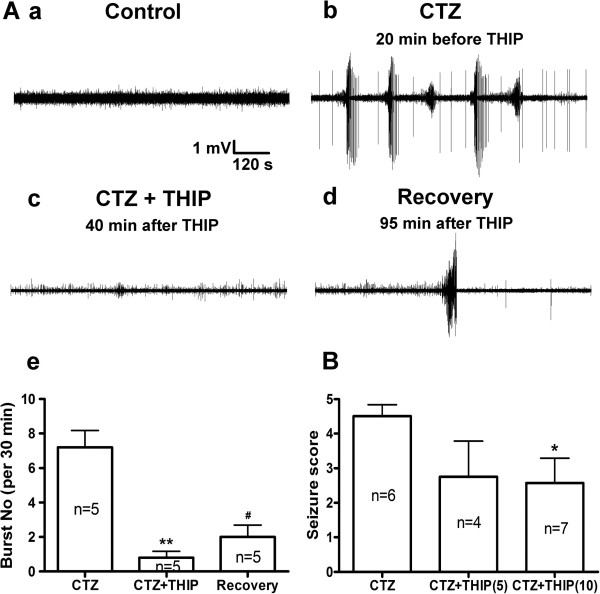
THIP inhibits CTZ-induced epileptiform activity and seizure behavior. Aa-d, Typical traces showing ‘silent’ baseline activity of hippocampal CA1 neurons in control condition (a), synchronized epileptiform bursting activities induced by CTZ (5 μmol) (b), inhibition of THIP (4 mg /kg) on burst activity (c), and the recovery after the THIP injection (d). Ae, Bar histogram showing group data of THIP inhibition on CTZ-induced epileptiform burst activities. B, Bar histogram showing group data of CTZ-induced (5 μmol) seizure behavioral score and its significant attenuation by pre-treatment with THIP (10 mg/kg). THIP(5): 5 mg/kg THIP; THIP(10): 10 mg/kg THIP. * p < 0.05 and ** p < 0.01 in comparison with CTZ injection alone; # p < 0.05 for recovery, in comparison with CTZ + THIP.